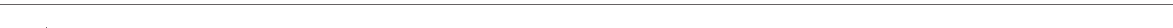
FigUre 5 | Intra-articular (IA) boost leads to systemic inflammation favoring neutrophilic joint effusion. At 30 weeks post-initial prime, animals received an IA boost with pooled citrullinated Vim59 and 66, Fg79, and Agg89 plus incomplete Freund’s adjuvant (IFA) ( n = 3) or IFA alone ( n = 2) as a control. (a) Left panel: Plasma C-reactive protein (CRP) level with citrullinated peptides + IFA and IFA alone. Right panel: Plasma CRP level for citrullinated peptides + IFA and all controls at day 1 post-IA boost (Mann–Whitney test). (B) Complete blood counts of lymphocyte and neutrophils after IA boost with citrullinated peptides + IFA and IFA alone. (c) Non-human primate multiplex 23-cytokine array after IA boost with citrullinated peptides + IFA and IFA alone. Data are ratio of levels to the pre-IA injection level. ** P < 0.001 Mann–Whitney test. (D) Synovial fluid smears stained with May-Grünwald Giemsa showing typical cellular counts of transient swelling with IFA alone 4 days post-IA injection (left panel) and citrullinated peptides + IFA 14 days post-IA boost (middle panel). 20 × magnification. Quantification of at least five high power fields of synovial fluid smears comparing animals with transient swelling on IFA injection (controls) and those who received citrullinated peptides + IFA and presented prolonged swelling. Data are mean ±